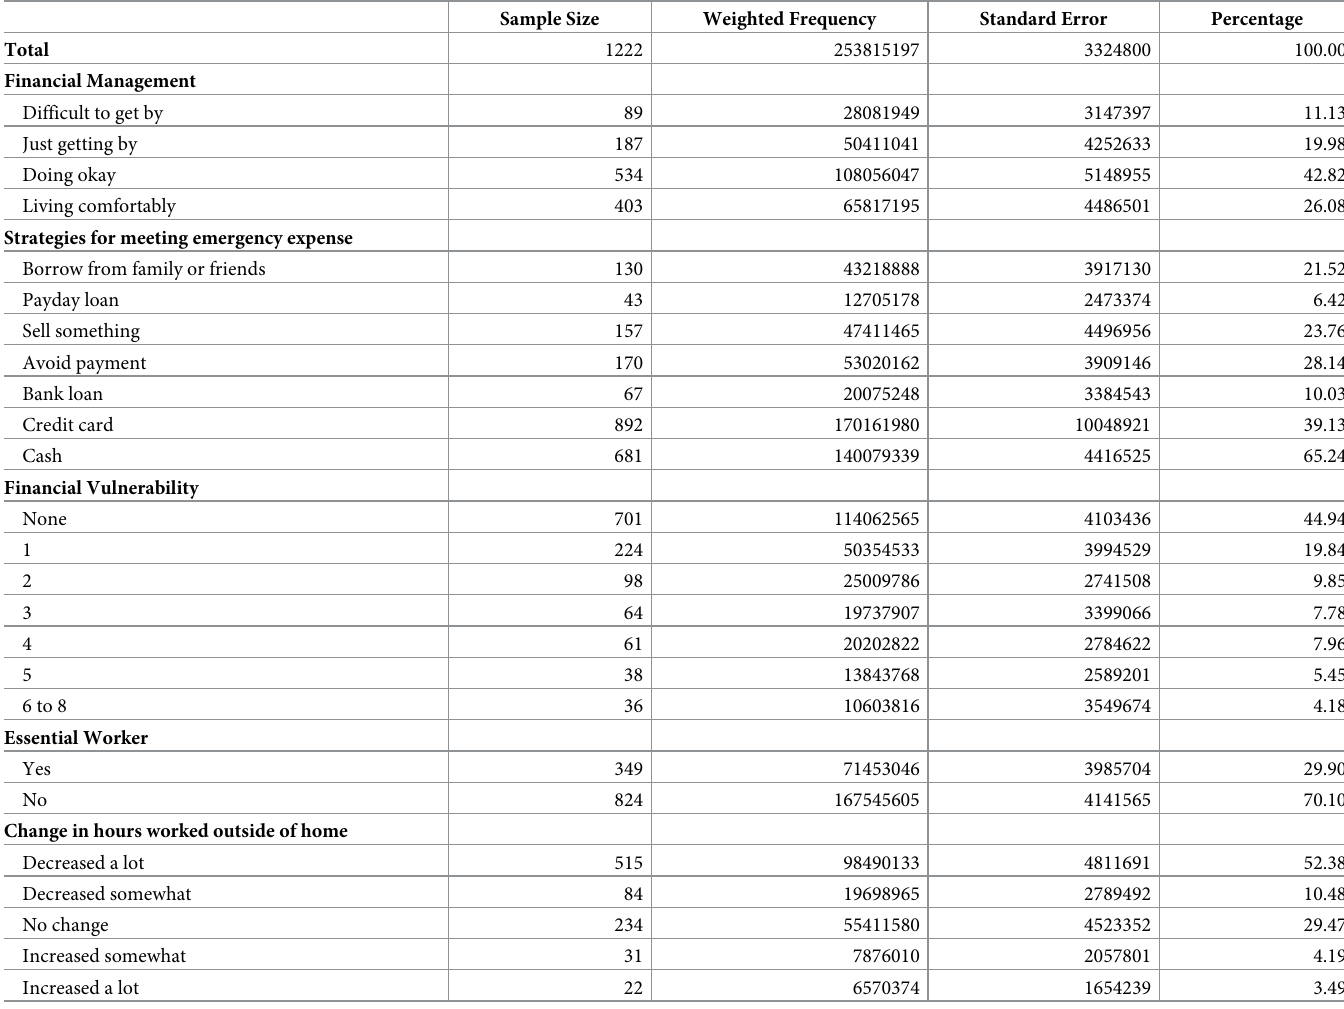
Table 3. Financial